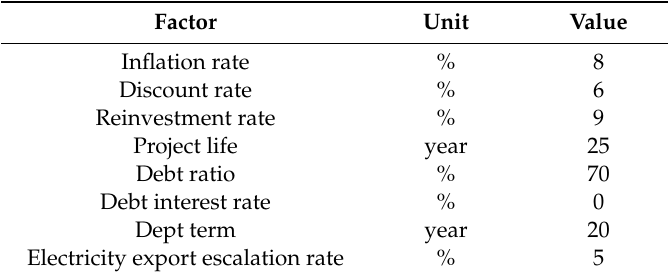
Table 9. Financial